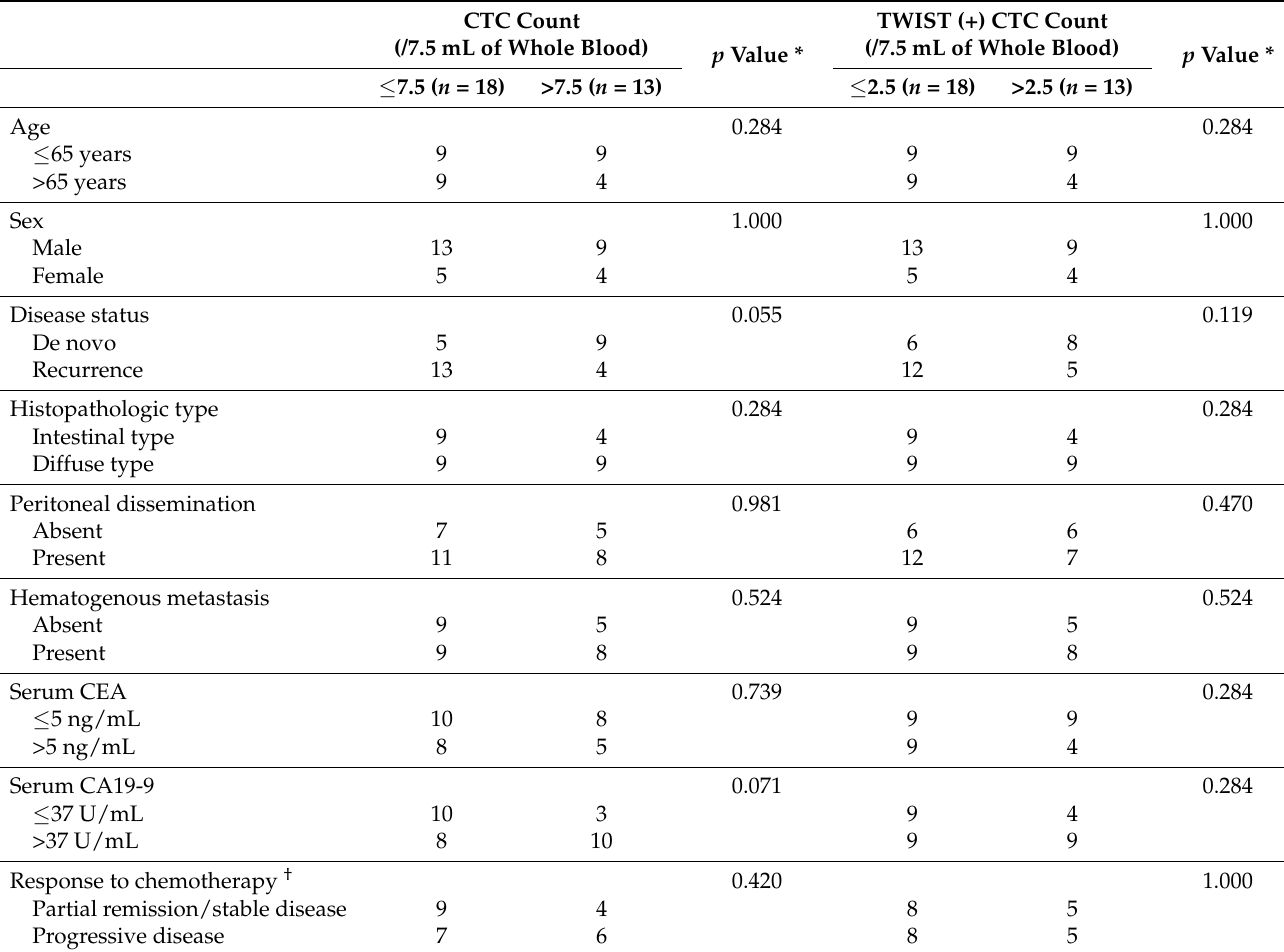
Table 3. Clinicopathologic characteristics of the 31 patients with metastatic gastric cancer according to the level of circulating tumor cells (CTC) and TWIST (+) CTCs. CTC Count (/7.5 mL of Whole